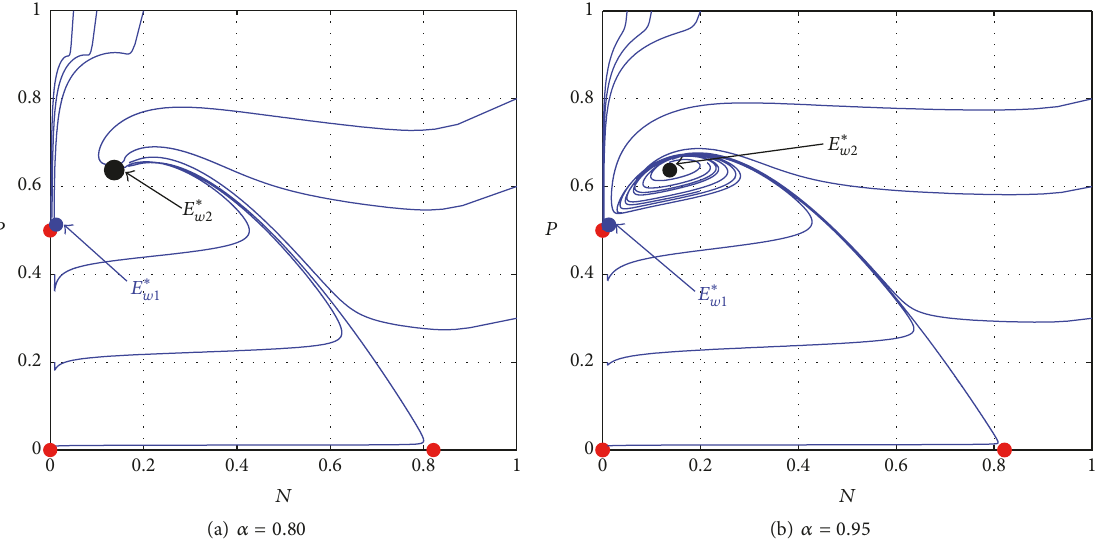
Figure 3: Phase portrait of system (6). The values of parameters are 𝑠 = 0.02 , 𝑘 = 0.5 , 𝑚 = 0.2 , ℎ = 0.3 , 𝜔 = 0.7 , 𝑎 = 1 , 𝑏 = 0.5 , 𝑐 = 0.05 , and Δ𝑡 = 0.1